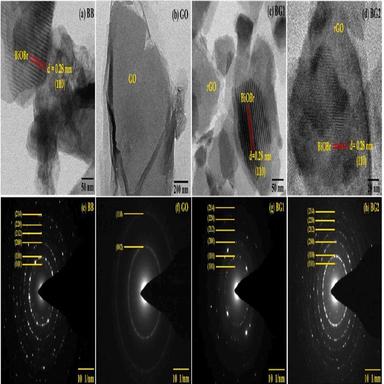
TEM images and SAED patterns of (a, e) BB, (b, f) GO, (c, g) BG1 and (d, h) BG2.